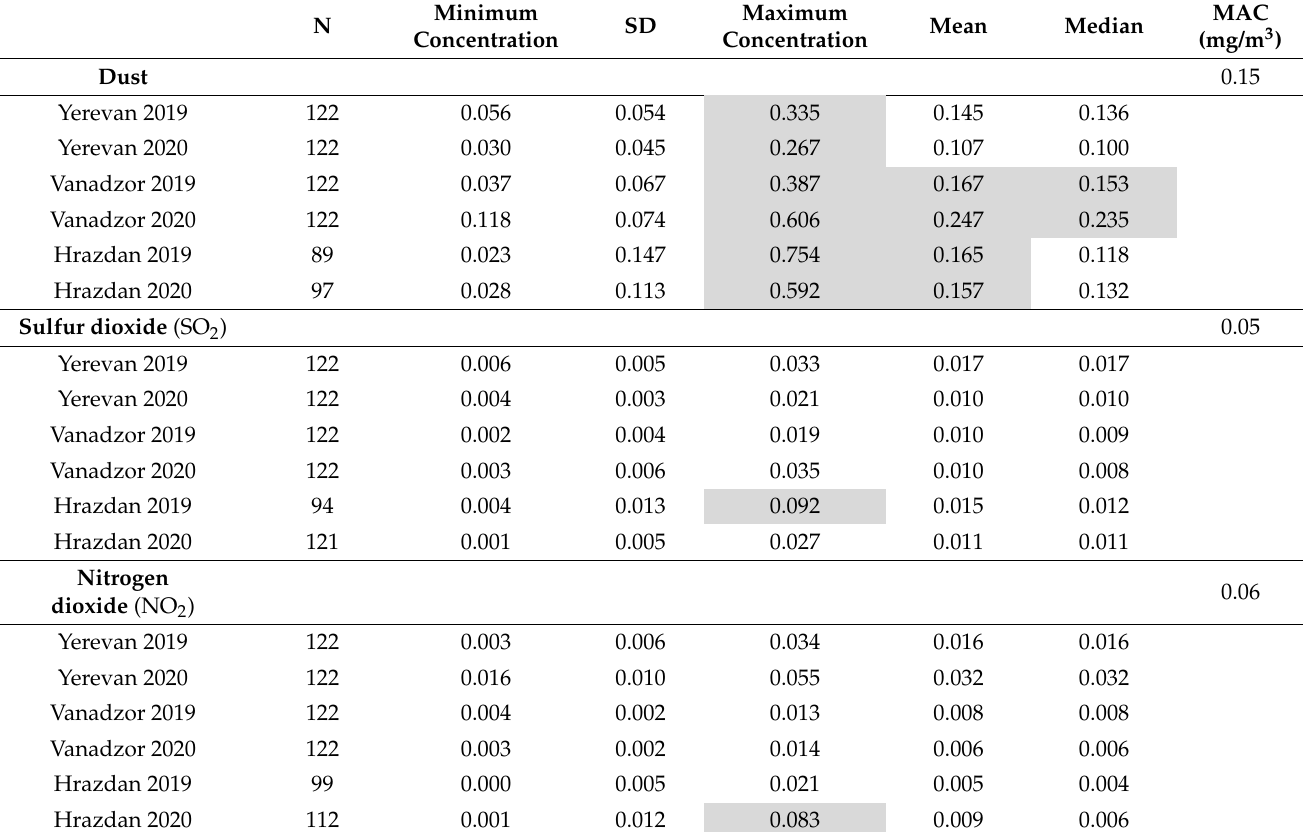
Table 1. Dust, SO 2 and NO 2 concentrations (mg/m 3 ) in Yerevan, Vanadzor and Hrazdan during March–June 2019 and 2020 (concentration exceeding the MAC are marked with